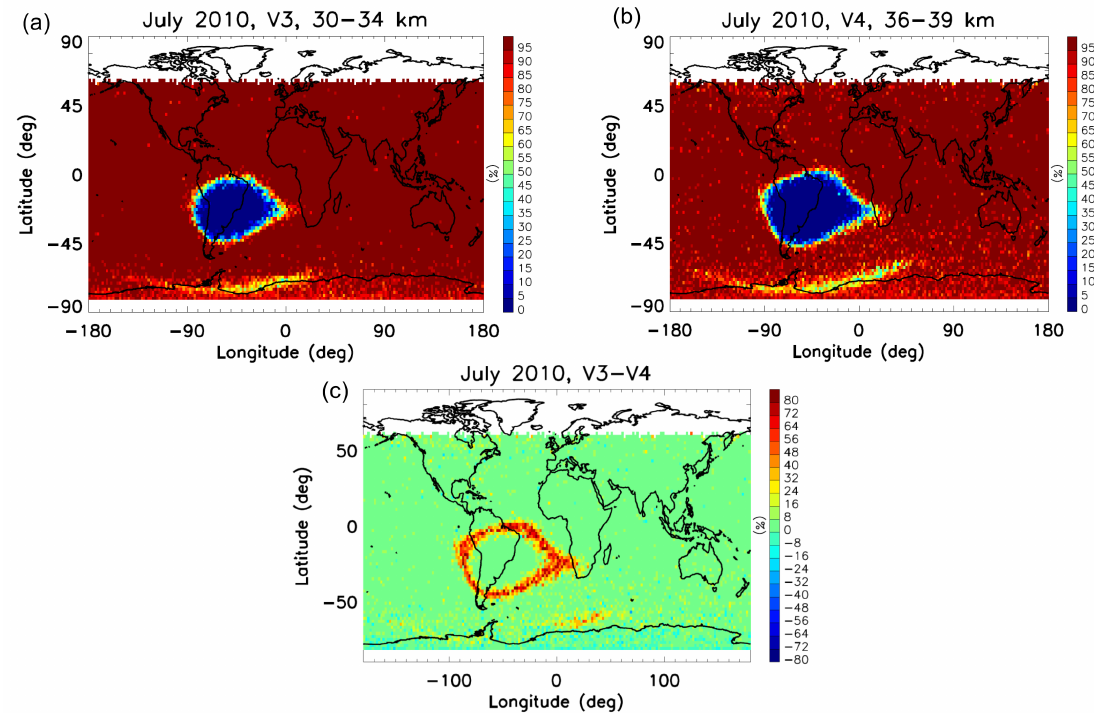
Figure 7. Spatial distribution of the calibration success rates for V3 and V4 for the month of July 2010. The data are binned in 2 ◦ × 2 ◦ in latitude and longitude. Panel (c) shows the difference (V3–V4) in the success rates between the two